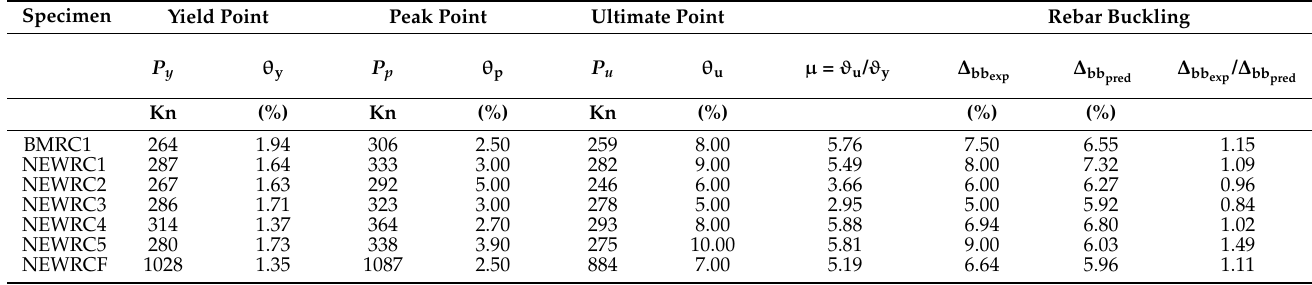
Table 3. Details of the test results.